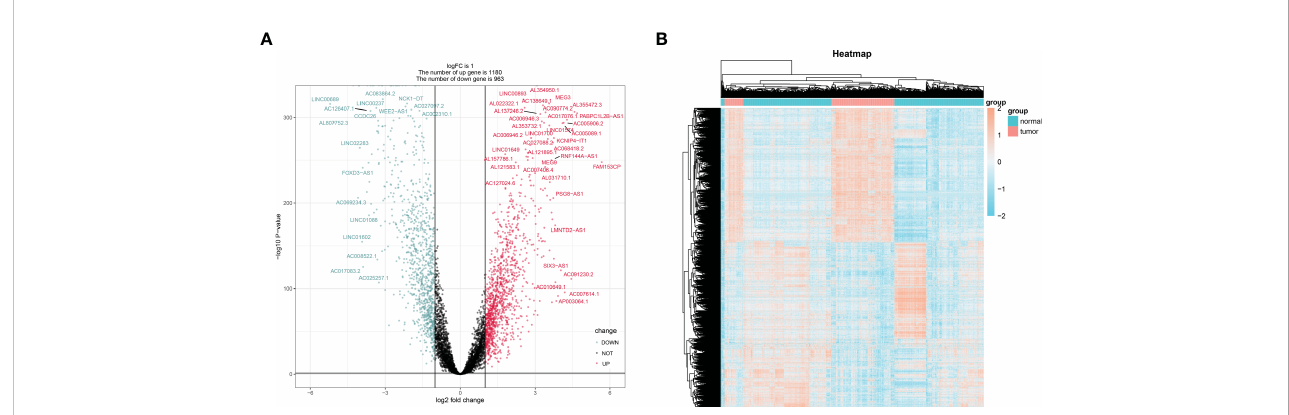
FIGURE 2 The screening of differentially expressed lncRNAs lncRNAs. The volcano graph (A) and heatmap (B) showed that 1180 lncRNAs were down-regulated and that 963 lncRNAs were up-regulated in tissues of LGG compared to normal tissues.